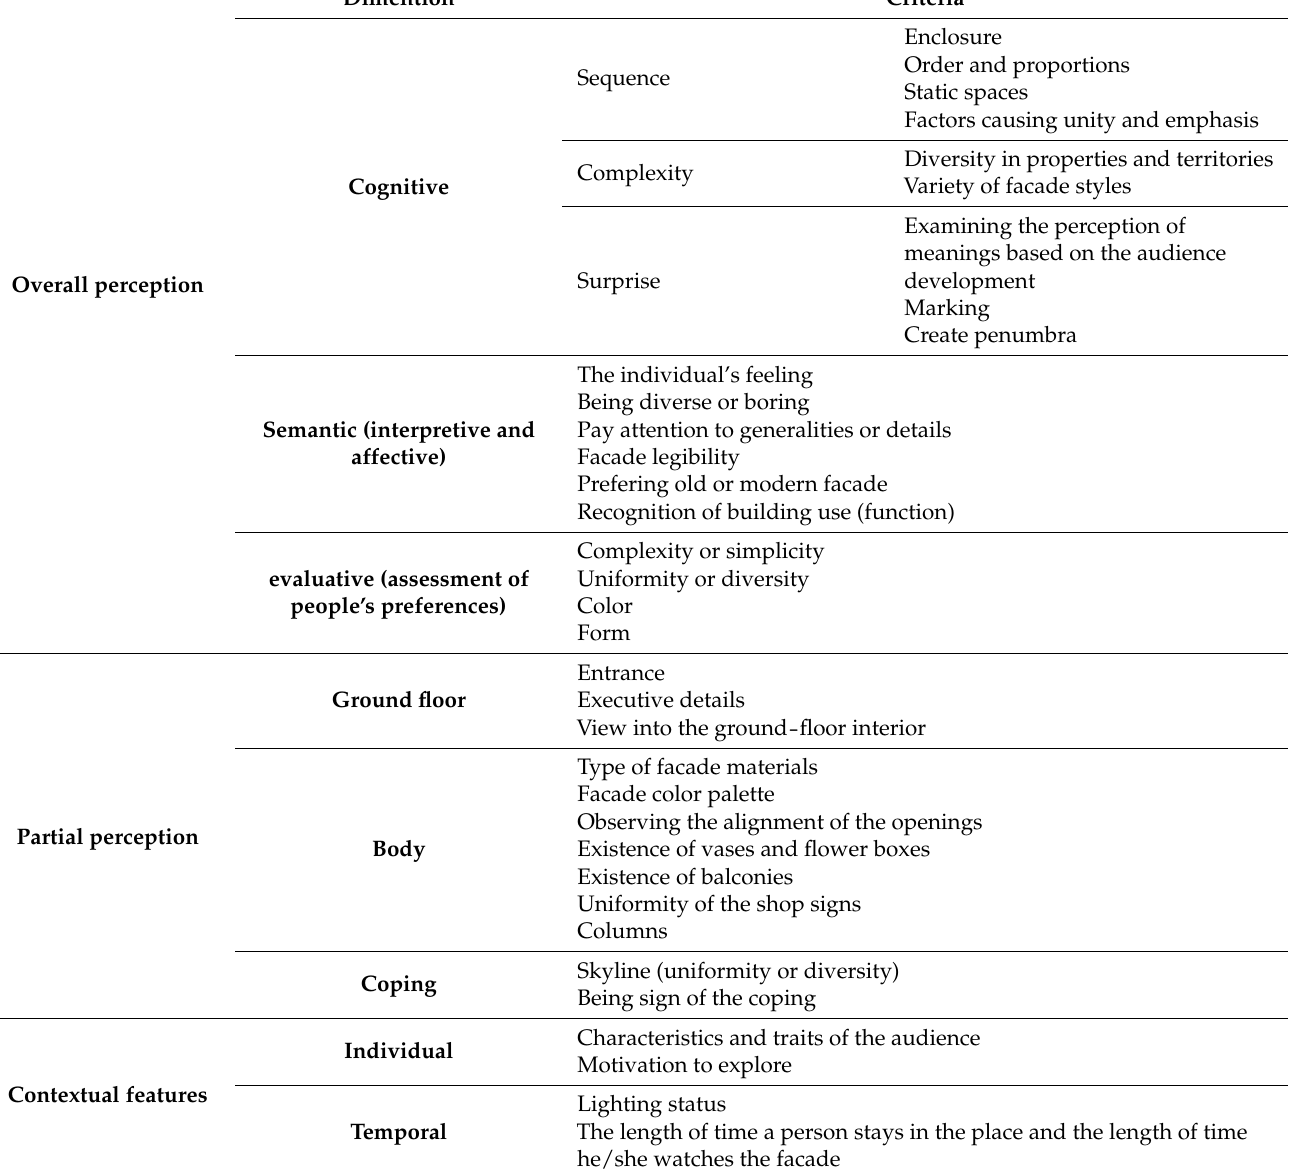
Table 3. Items in the research questionnaire (Source: